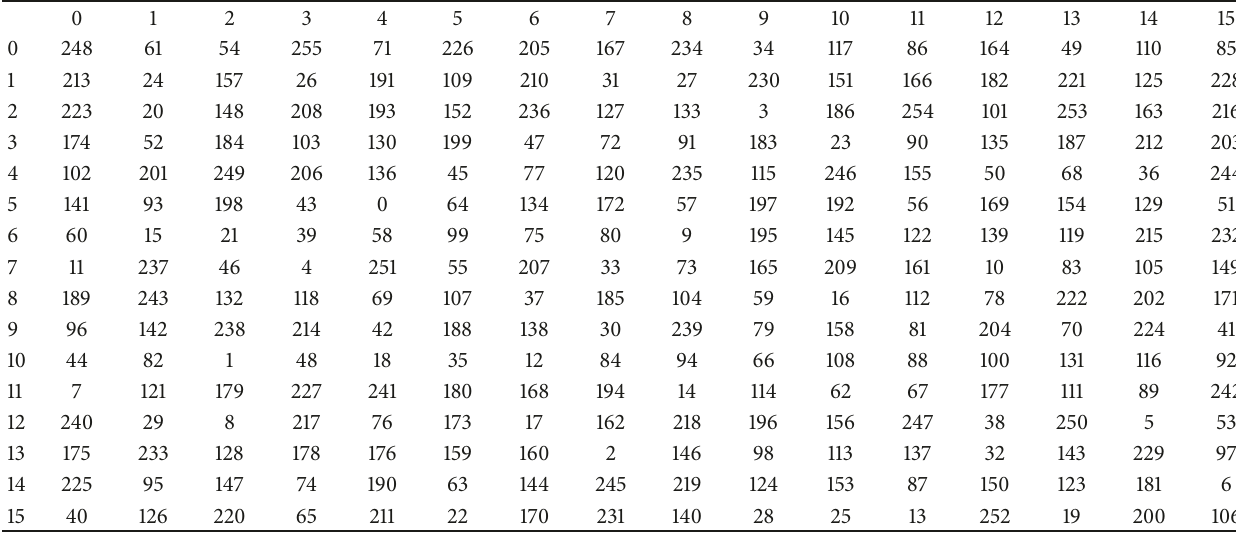
Table 4: The proposed 8 × 8